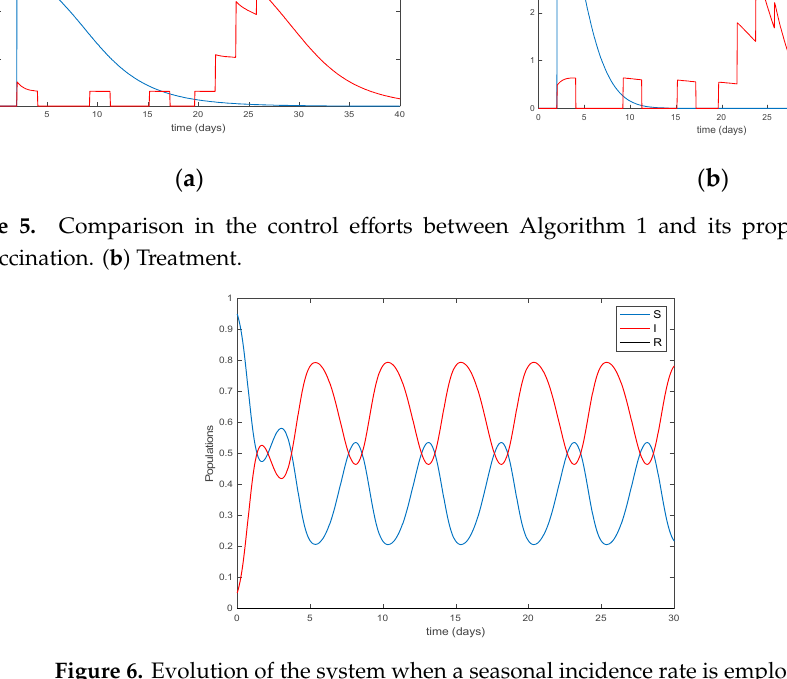
Figure 6. Evolution of the system when a seasonal incidence rate is employed.